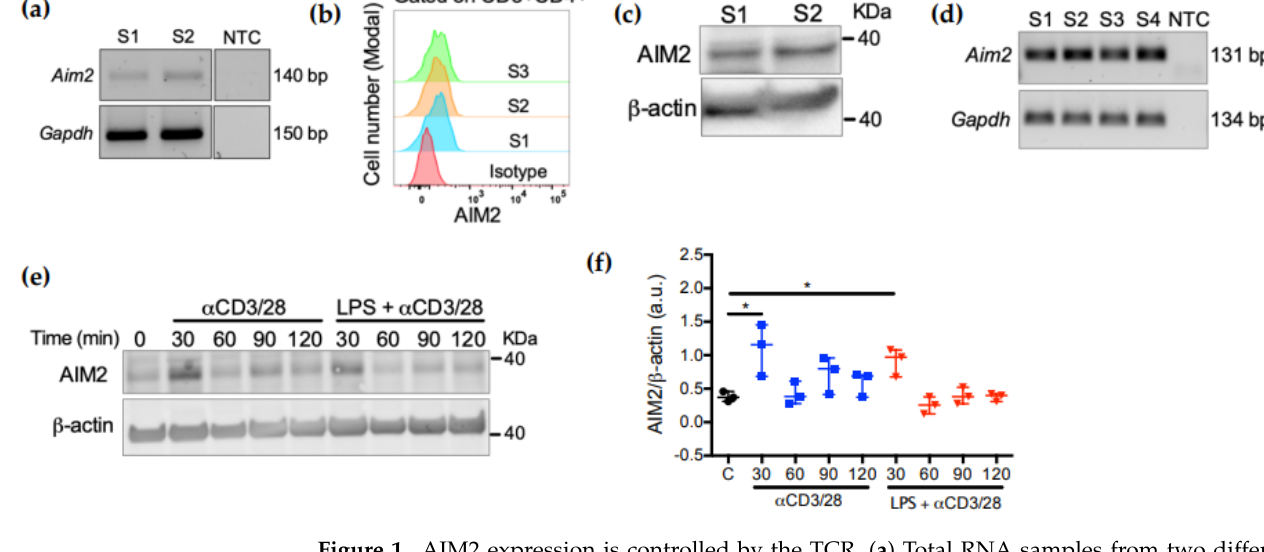
Figure 1. AIM2 expression is controlled by the TCR. ( a ) Total RNA samples from two different subjects (S1 and S2) were subjected to qRT-PCR for the amplification of Aim2 mRNA and visualized on an agarose gel after 30 cycles. NTCs were run on the same gel but were not contiguous. ( b ) Flow cytometry analysis of AIM2 expression in CD3 + CD4 + T cells from peripheral blood mononuclear cells (PBMCs) of three different subjects (S1–S3). ( c ) Western blot analysis of AIM2 expression in CD4 + cells purified from PBMCs of two different subjects (S1–S2). ( d ) Total RNA samples from four different mouse CD4 + T cell samples (S1–S4) were subjected to qRT-PCR for the amplification of Aim2 mRNA and visualized on an agarose gel after 30 cycles. ( e ) Western blot analysis of AIM2 expression in mouse spleen CD4 + T cells. CD4 + T cells were stimulated with anti-CD3 and anti-CD28 ( α CD3/28) antibodies with or without LPS pre-stimulation (2 h) and total protein extracts were collected at the indicated timepoints. Anti-mouse AIM2 and anti-mouse β -actin primary antibodies were used after immunoblot for detection of AIM2 expression and loading control, respectively. ( f ) Quantification of blot images performed using ImageJ software (au; arbitrary units). Data were analyzed using Sidak’s multiple comparison test and are displayed as scatter plot with median ± range; * p < 0.05. Data are representative of three different experiments with similar results. NTC = non-template control.